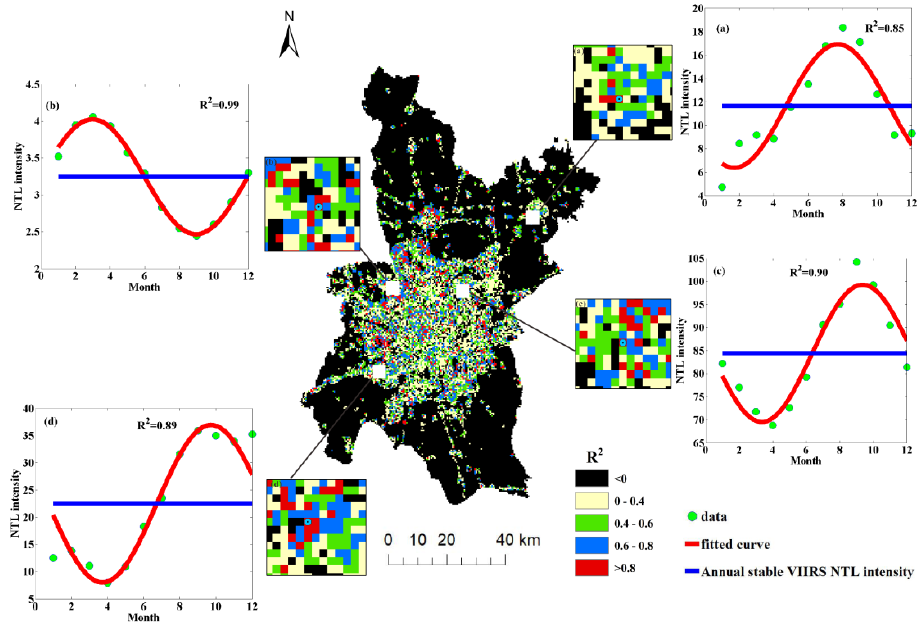
Figure 4. Observed seasonal variation of NTL intensity at the pixel scale from Wuhan in 2013: ( a – d ) curve-fitted of four different pixels’ seasonal variation.